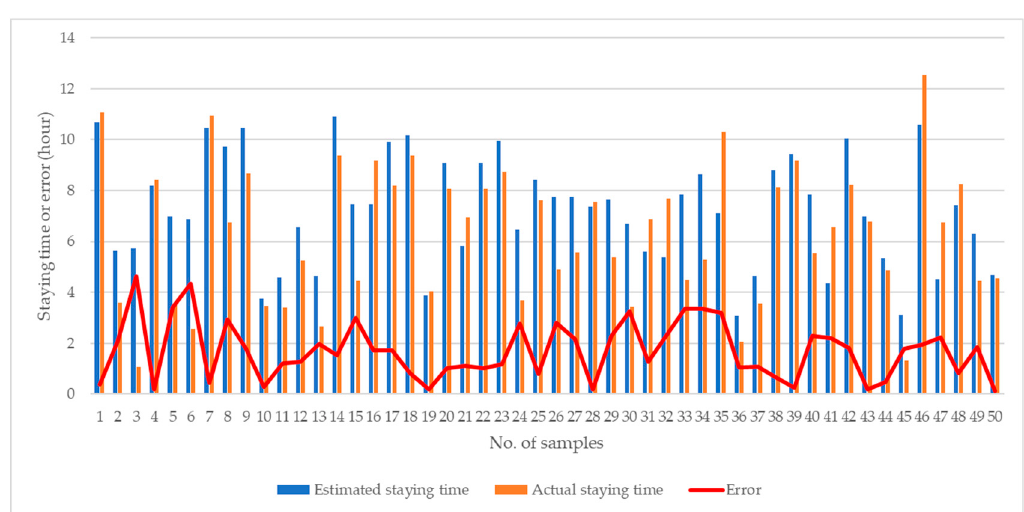
Figure 20. Accuracy comparison for estimation of time of stay.